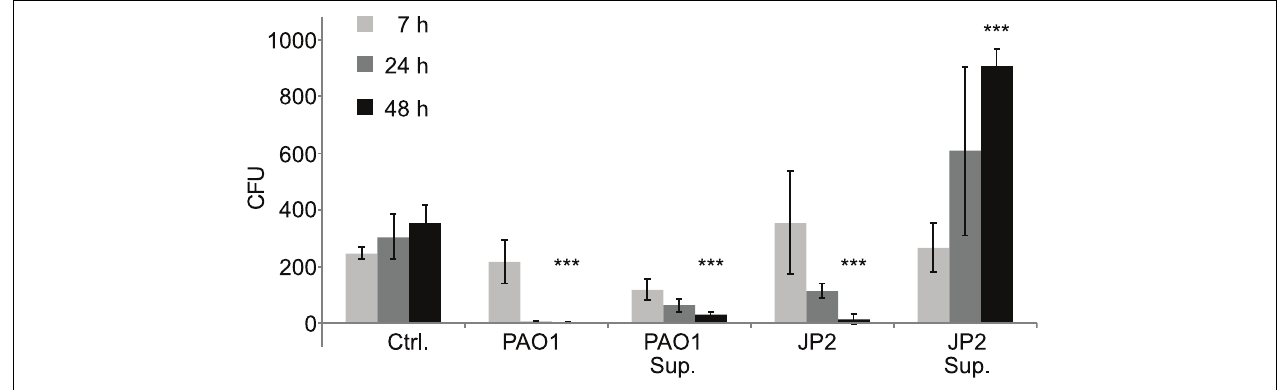
FIGURE 3 | Liquid co-cultures of wild type yeast with Pseudomonas reveal growth inhibitory effect of Pseudomonas supernatant. Overnight cultures of S. cerevisiae wild-type strain W303 and P. aeruginosa (wild-type strain PAO1 or the (cid:49) rhlI (cid:49) lasI mutant PAO-JP2) were both adjusted to OD 600 ∼ 0.01 and incubated together at 30 ◦ C under constant agitation. Additionally, S. cerevisiae was grown under the same conditions in the presence of PAO1 or PAO-JP2 supernatant. After 7, 24 and 48 h samples were taken, diluted in DDW and plated on selective YPD agar containing 50 µ g/mL gentamicin (in order to inhibit bacterial growth and thus monitor only yeast growth/viability). Yeast viability was reduced in the presence of the bacteria for both the wild-type and the mutant, presumably due to competition for resources. However, only the supernatant of PAO1 inhibited yeast growth, indicating inhibition due to bacterial virulence factors or other QS-regulated secondary metabolites. Values are averages of three experiments ( ± standard deviation). The significance of the variance between groups was calculated using a one-way ANOVA test, followed by pairwise comparisons using Tukey multiple comparison of means. Key: *** p ≤